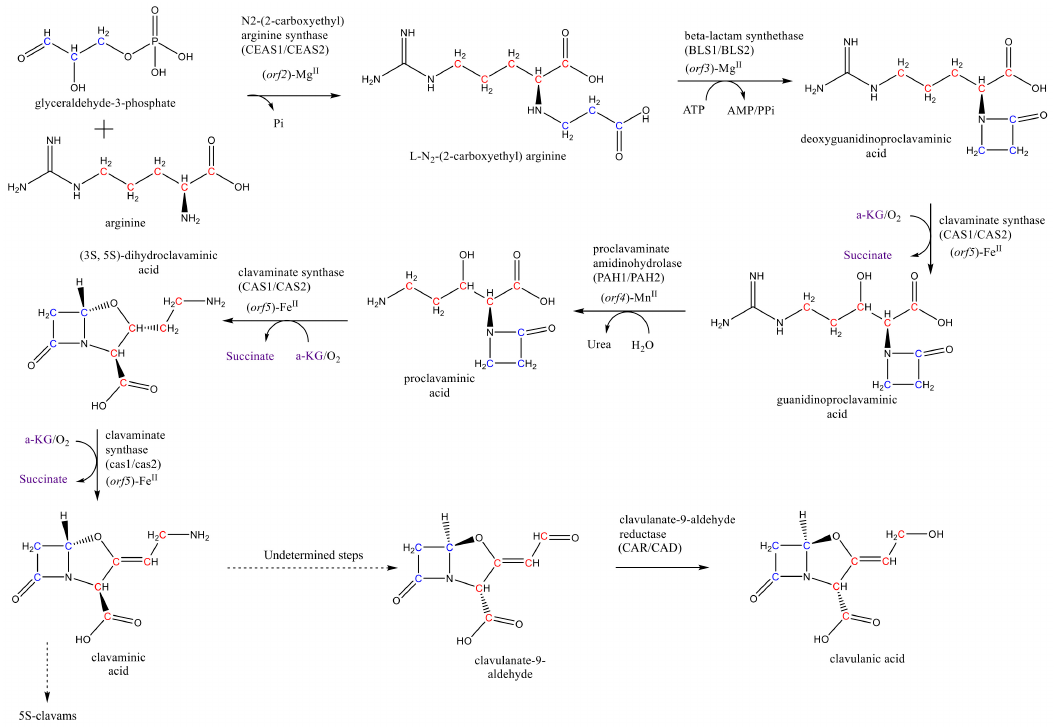
Figure 1. Clavulanic acid biosynthesis pathway.